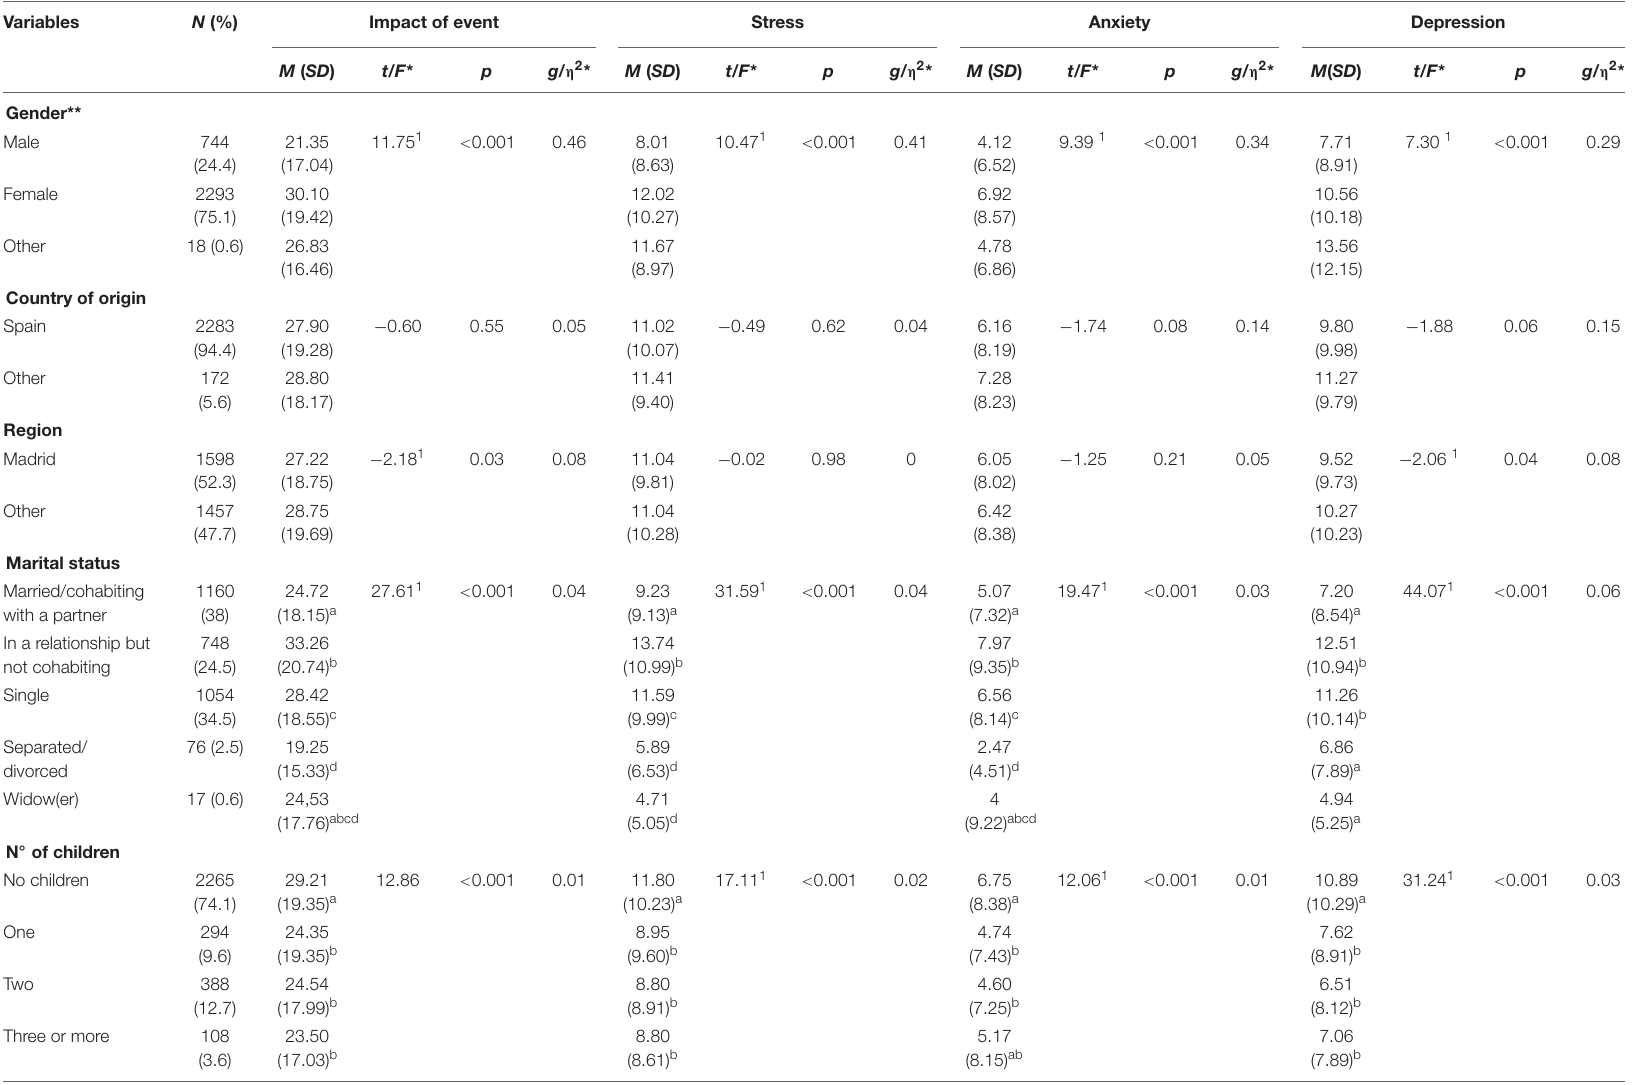
TABLE 2 | Association between demographic variables and the psychological impact of the COVID-19 pandemic as well as mental health status during the pandemic ( N = 3055). Variables N (%) Impact of event Stress Anxiety